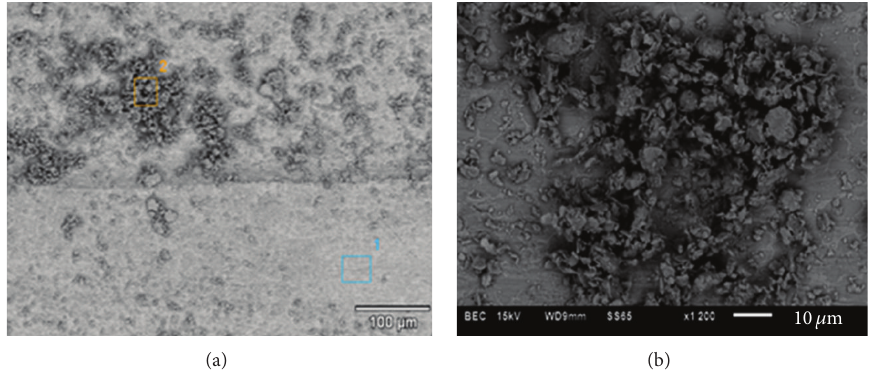
Figure 11: Wear track of the laser deposited Ni55Ti45 after sliding against a tungsten carbide